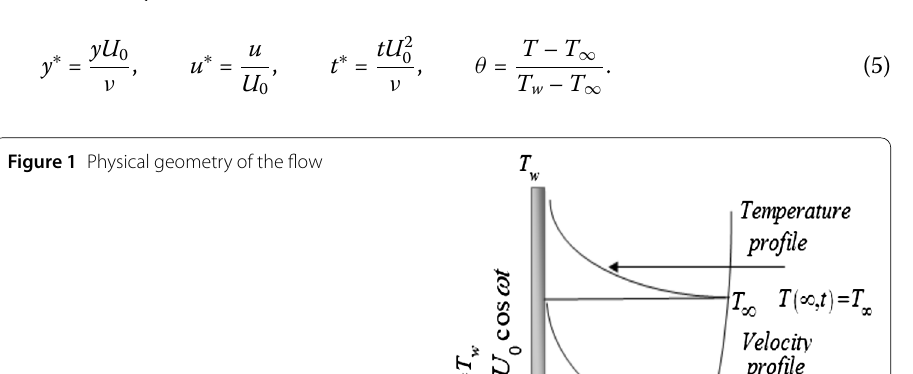
Figure 1 Physical geometry of the